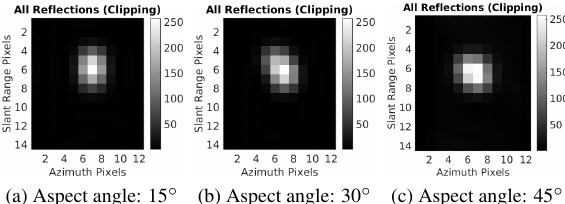
Figure 10. Simulated phase center positions for street signs in azimuth and range; signal incidence angle: 40 ◦ ; blue: single reflection, green: double reflection, red: triple reflection, magenta: fourfold reflection, cyan: fivefold reflection, white: shadow. Unit on axes: meter.